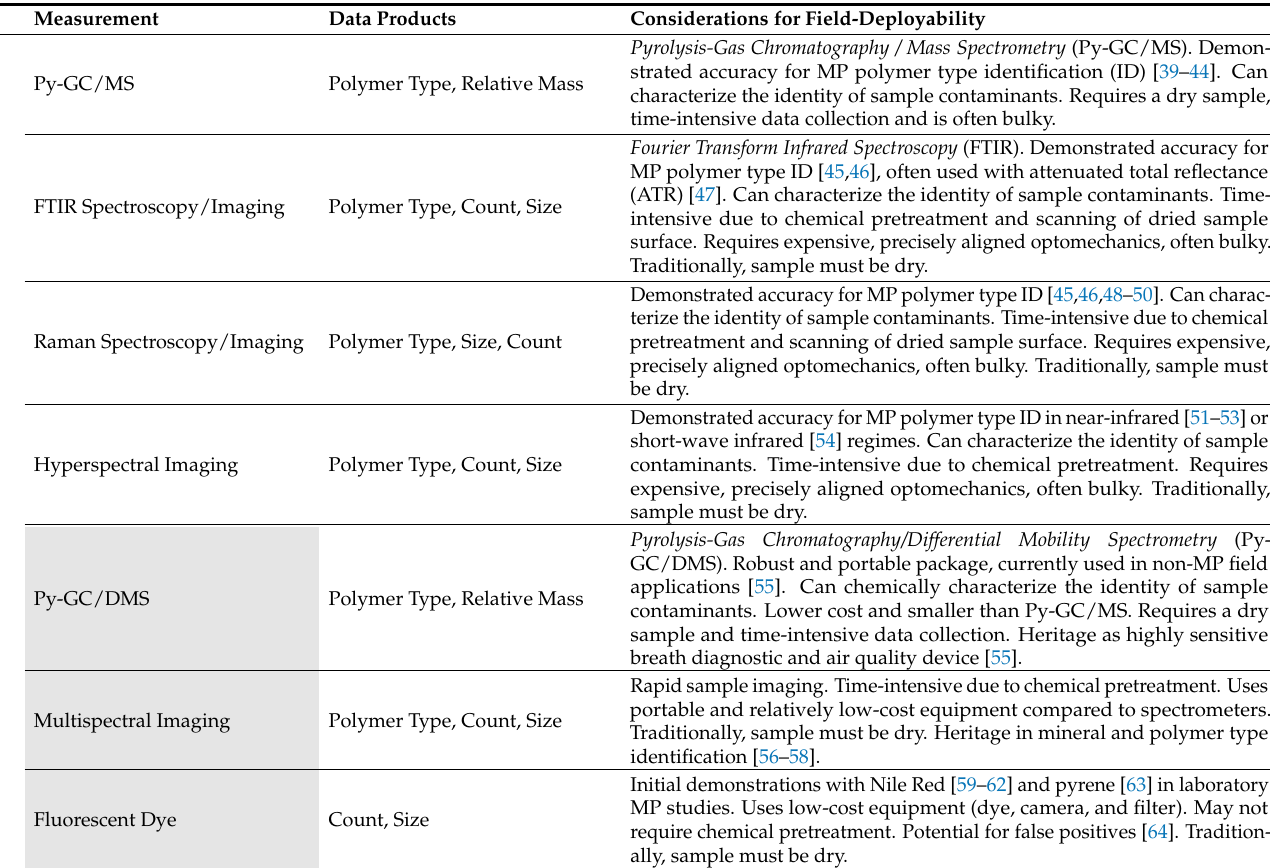
Table 1. Measurement techniques with applicability to MP analysis. Techniques evaluated in this paper are shaded gray; Impedance spectroscopy was investigated at the Woods Hole Oceanographic Institution (WHOI) and the remaining techniques were investigated at Draper. † Separation from Non-MPs is not a data product but instead is considered an enabling technology for measuring MP data products. * This observable has only preliminary data or is currently theoretical